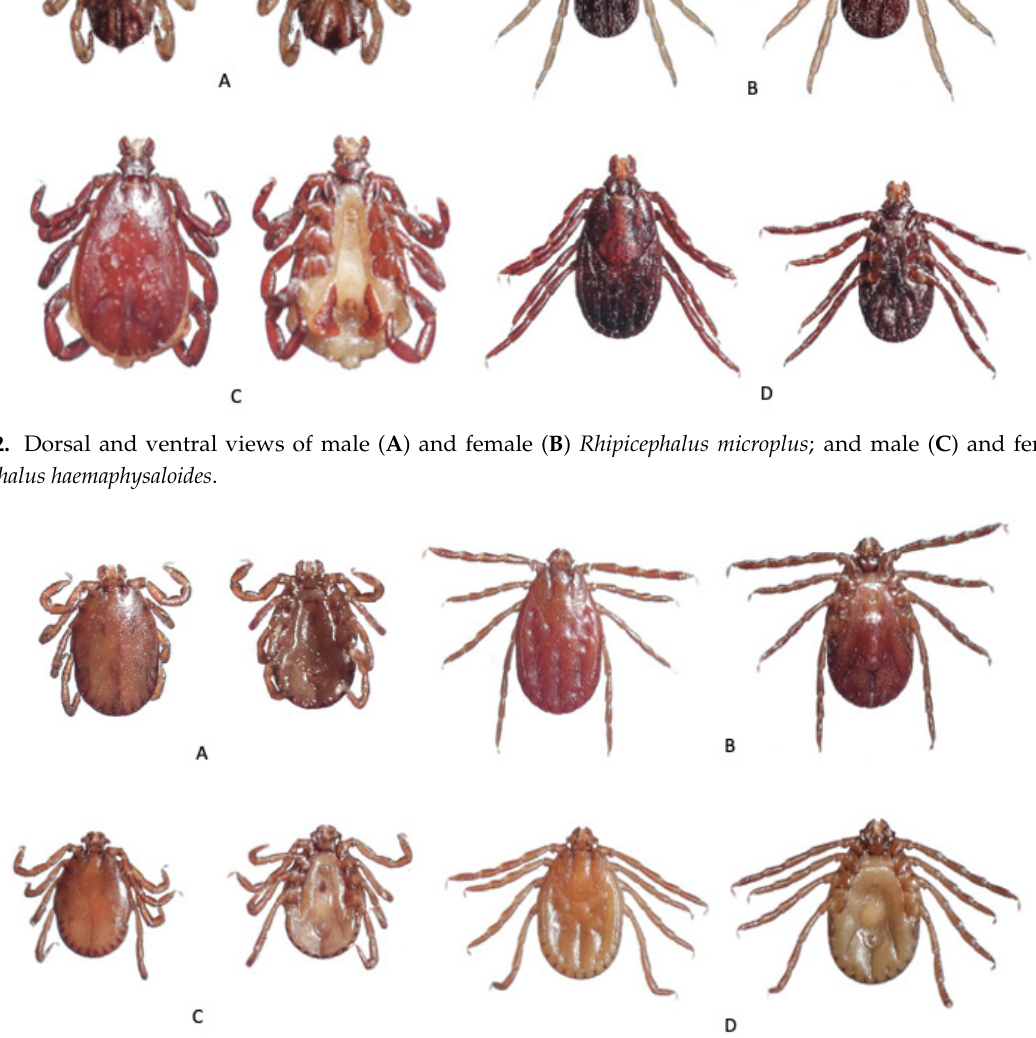
Figure 3. Dorsal and ventral views of male ( A ) and female ( B ) Haemaphysalis bispinosa ; and male ( C ) and female ( D ) Haemaphysalis spinigera .